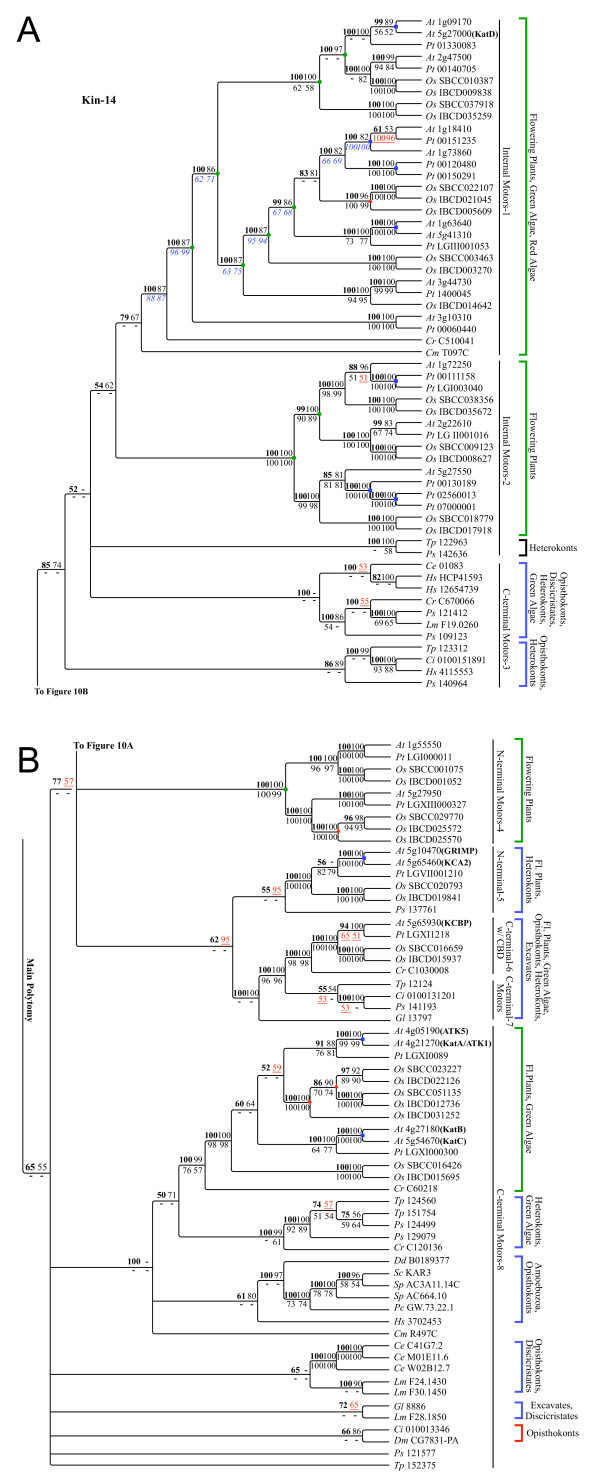
Expanded view of Kinesin-14 family. Expansion of the Kinesin-14 family from Fig. 2. Motor domain localizations are indicated adjacent to taxon labels. Experimentally studied Arabidopsis kinesins are indicated in parenthesis with its published name in bold. Green brackets indicate plant specific groups, mixed clades are shown in blue brackets, black brackets indicate protozoan species and red brackets indicate groupings composed of opisthokonts. Green circles, blue squares and a red triangle indicate gene duplications in flowering plants, dicots and monocots, respectively. See Fig. 2 legend for an explanation of support values. For full names of species see Fig. 1 legend.